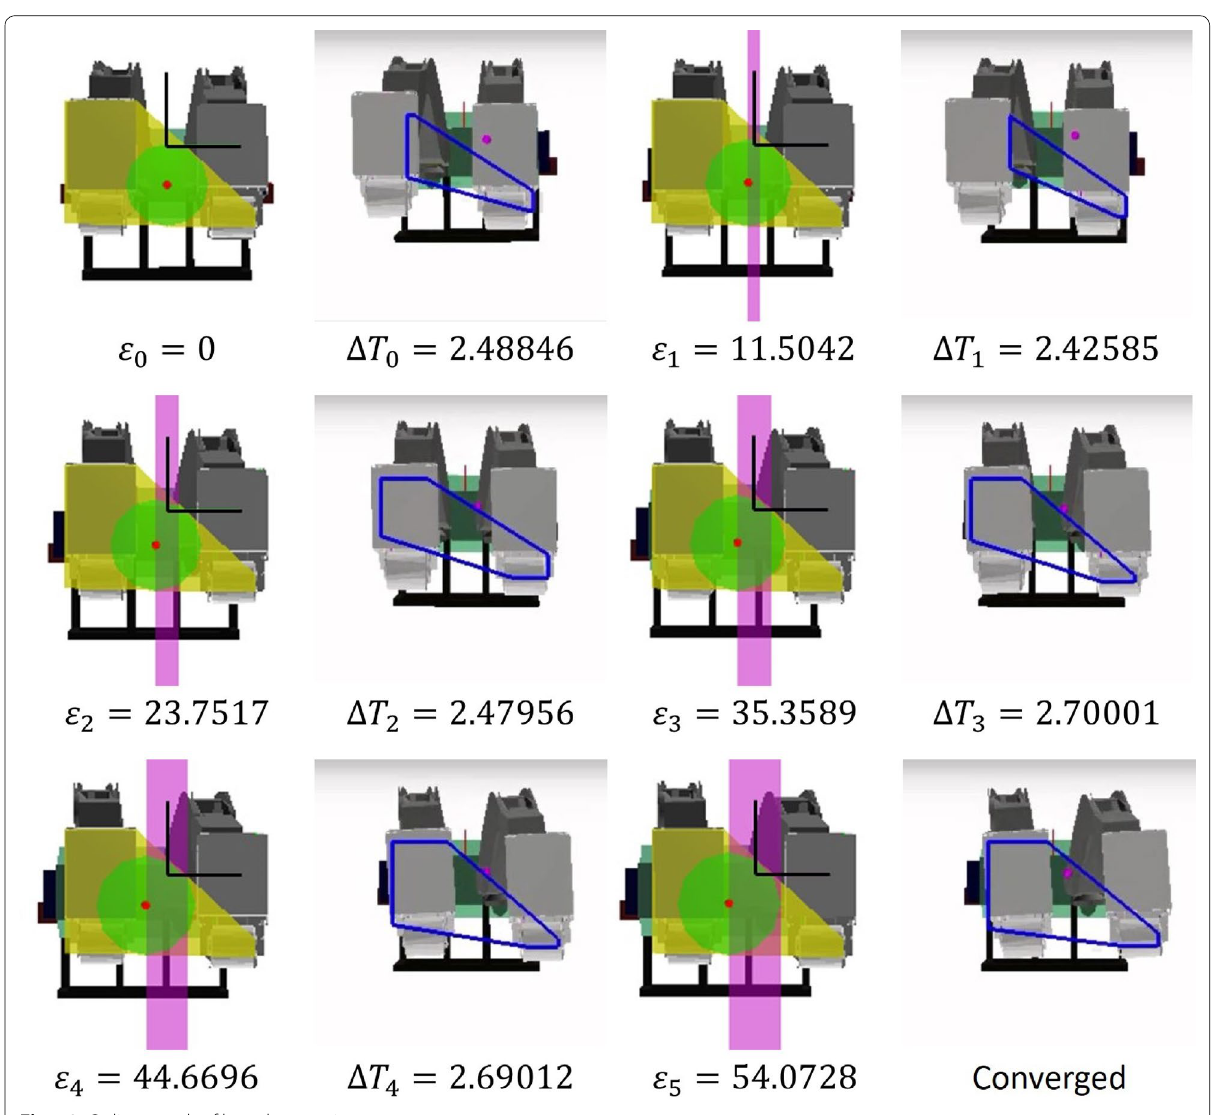
Fig. 18 Online search of lateral constraint